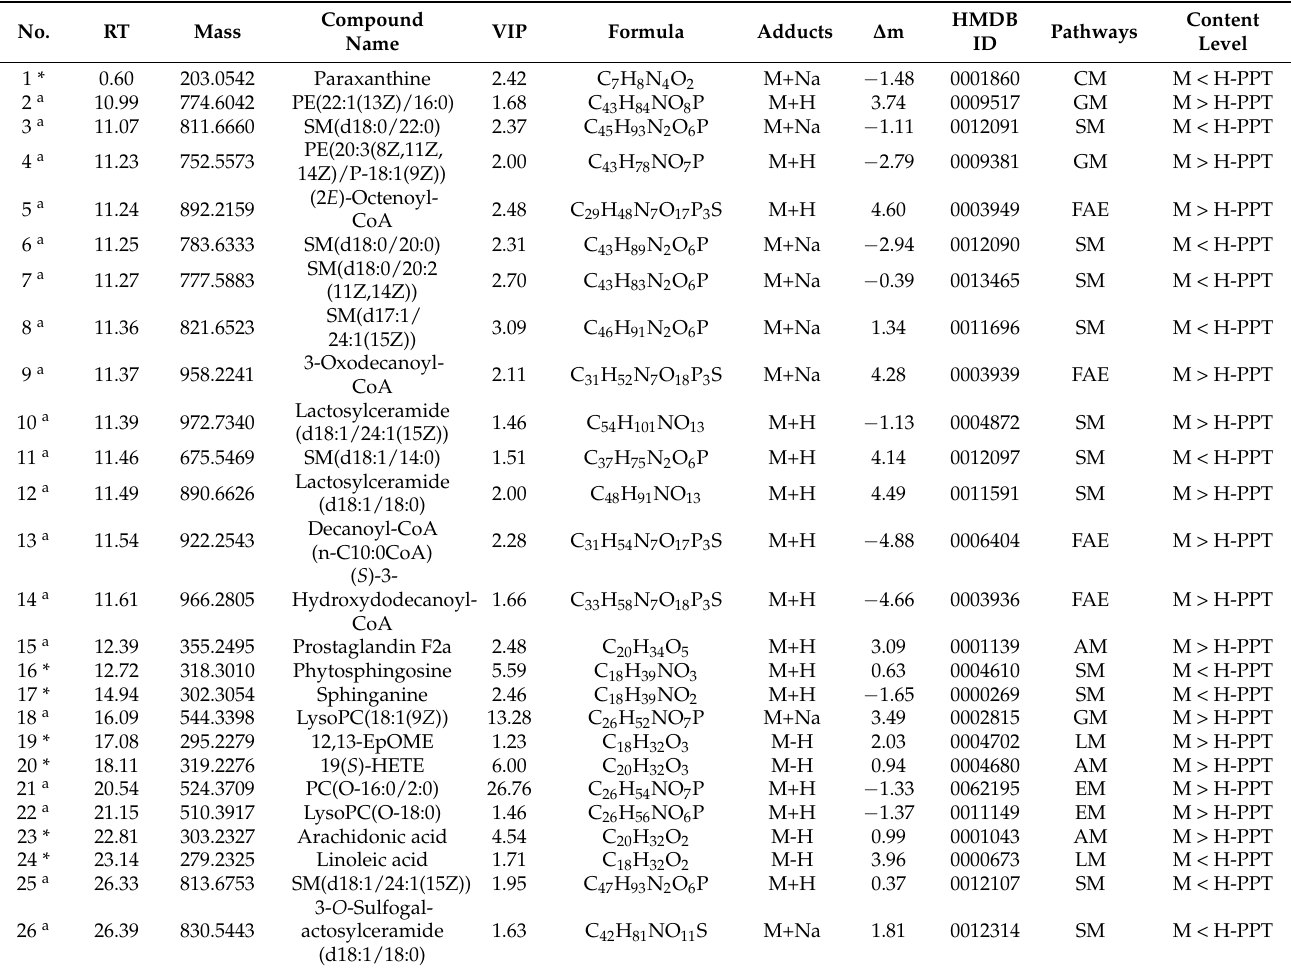
Table 3. Distinct metabolites identified in serum